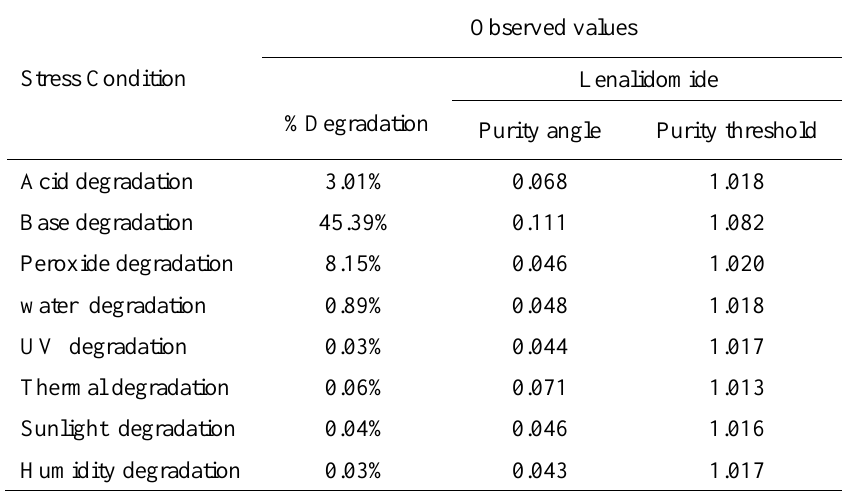
Table 1. Summary of the degradation results.